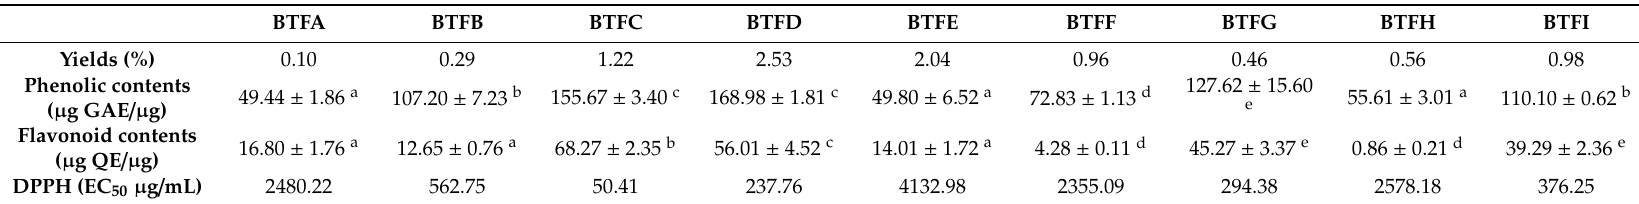
Table 2. Comparative analysis of total phenolic compounds and flavonoid content and DPPH radical scavenging of the crude extracts from leaves of Buchenavia tetraphylla